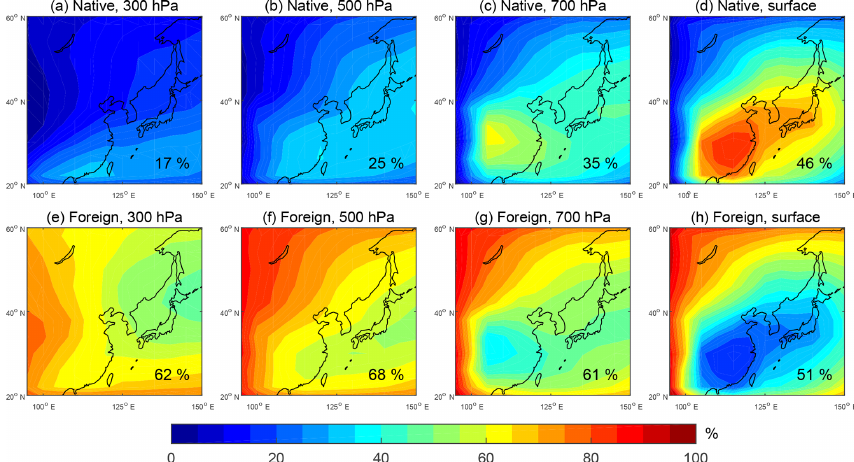
Figure 3. Fractional contributions (in %) of native ( a – d ) and foreign ( e – h ) ozone to ozone at different layers over East Asia in 2005. The regional mean of the fractional contribution is shown in the bottom right corner of each panel.